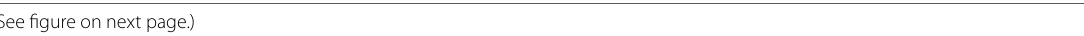
figure on next Fig. 3 Examples of stepwise thermal (left) and alternating-field (AF) (right) demagnetizations of samples from HD2092 Cores 1 and 2. Open (solid) circles are projection of vector endpoints on the vertical (horizontal) plane. Data points of temperature or AF steps adopted for calculation of characteristic remanent magnetization direction are colored, and those not used are in gray. Numbers attached to the data points are the peak temperature (°C) or peak AF